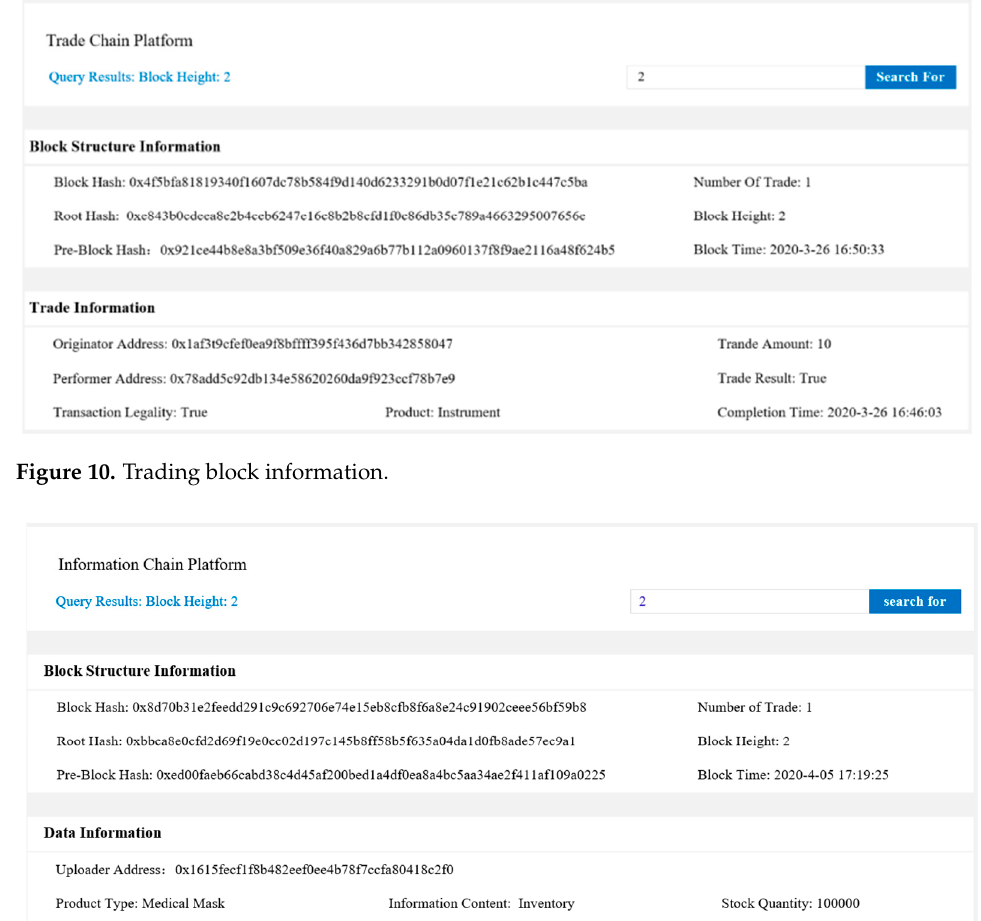
Figure 10. Trading block information.